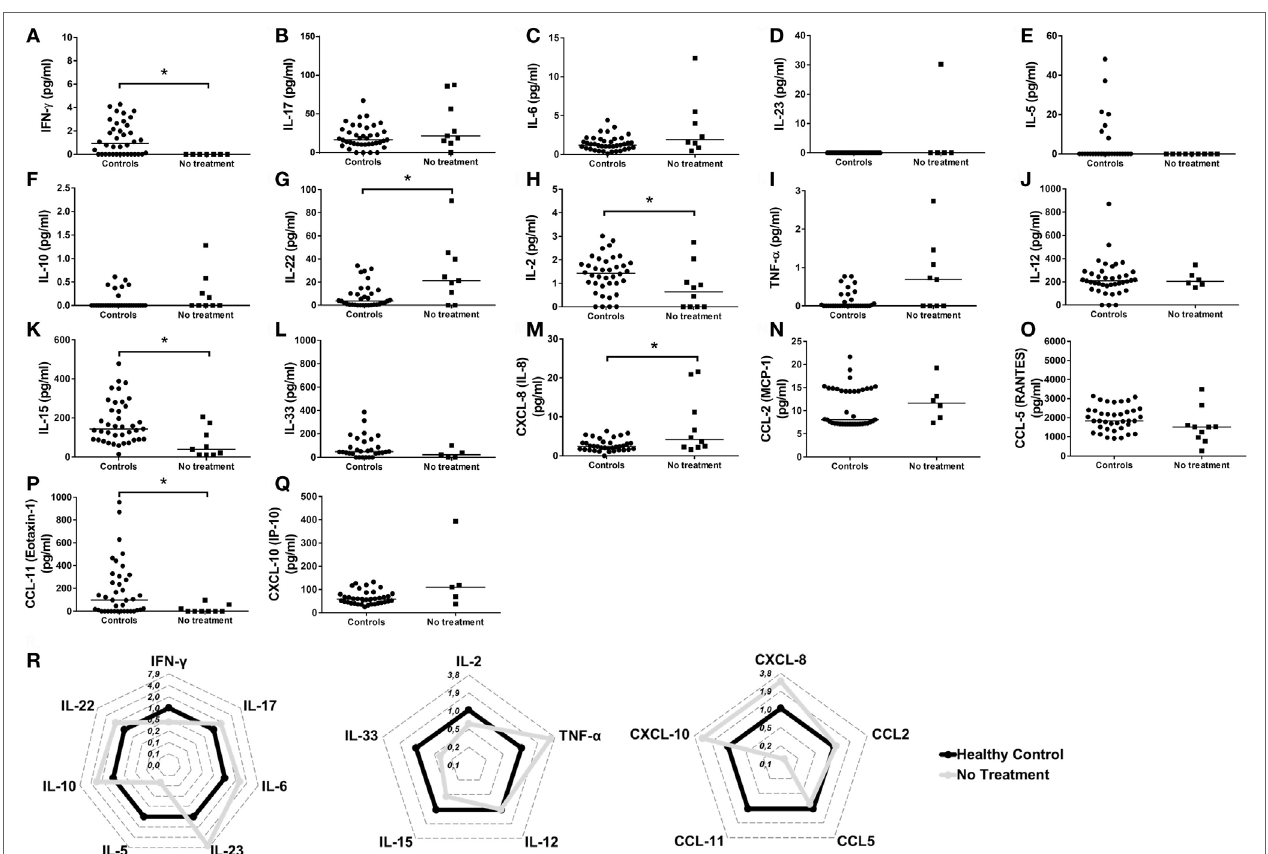
FigUre 2 | Serum profile of cytokines and chemokines in the pathogenesis of the endemic form (fogo selvagem) of pemphigus foliaceus. Levels of (a) IFN- γ , (b) IL-17, (c) IL-6, (D) IL-23, (e) IL-5, (F) IL-10, (g) IL-22, (h) IL-2, (i) TNF- α , (J) IL-12, (K) IL-15, (l) IL-33, (M) CXCL-8/IL-8, (n) CCL-2/MCP-1, (O) CCL-5/RANTES, (P) CCL-11/eotaxin-1, and (Q) CXCL-10/IP-10 from healthy donors (controls) and untreated patients with the endemic form (fogo selvagem) of pemphigus foliaceus (no treatment). Lines represent median. * p < 0.05, Mann–Whitney test. (r) Radar plot representation of serum cytokine and chemokine profile. Lines highlight the fold change in cytokine levels in pemphigus foliaceus patients (gray line) in relation to healthy donors (black line). Data were obtained by calculating the ratio between the median concentration of each cytokine in the pemphigus foliaceus (fogo selvagem) group and in the healthy group.